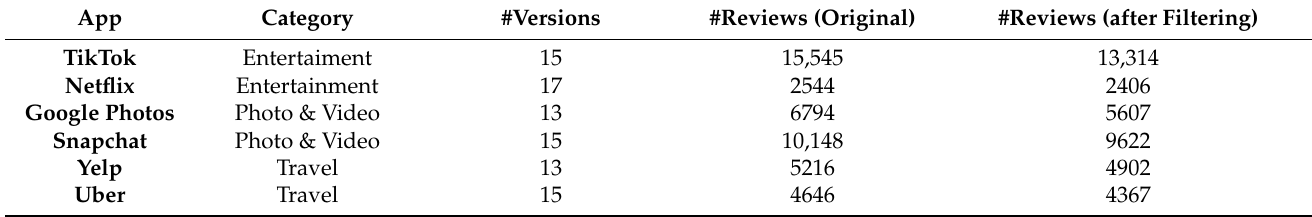
Table 3. Summary of selected apps and